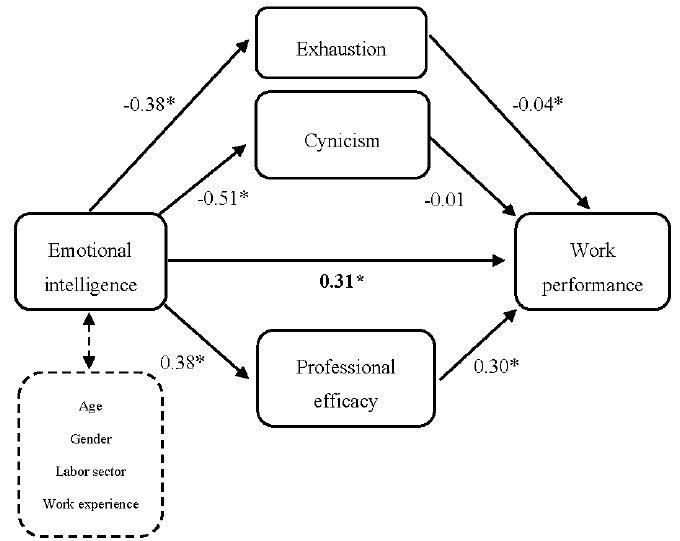
Figure 2. Mediation model of the burnout dimensions explaining the relationship between emotional intelligence and work performance. * p < 0.01.